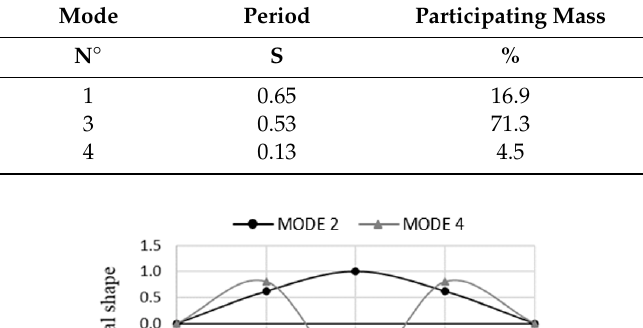
Table 4. Irregular bridge—modal properties. Table 3. Regular bridge—modal properties.